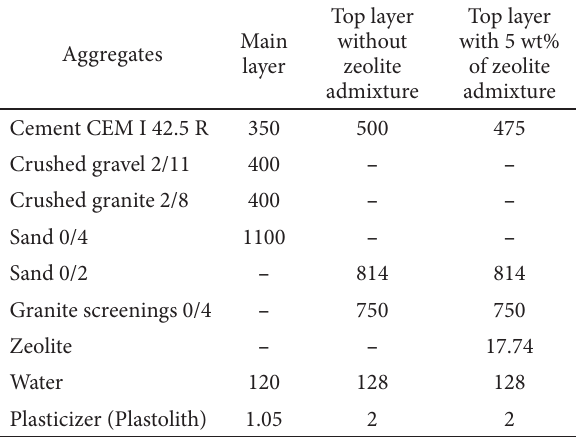
Table 1. Composition of concrete in pavement blocks (amounts